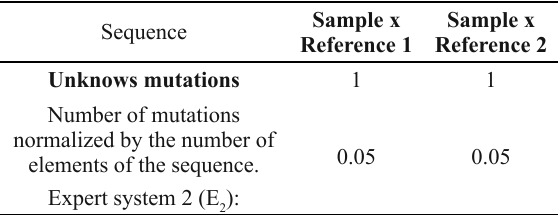
Veri fi cation the number of unknown mutations. Sequence